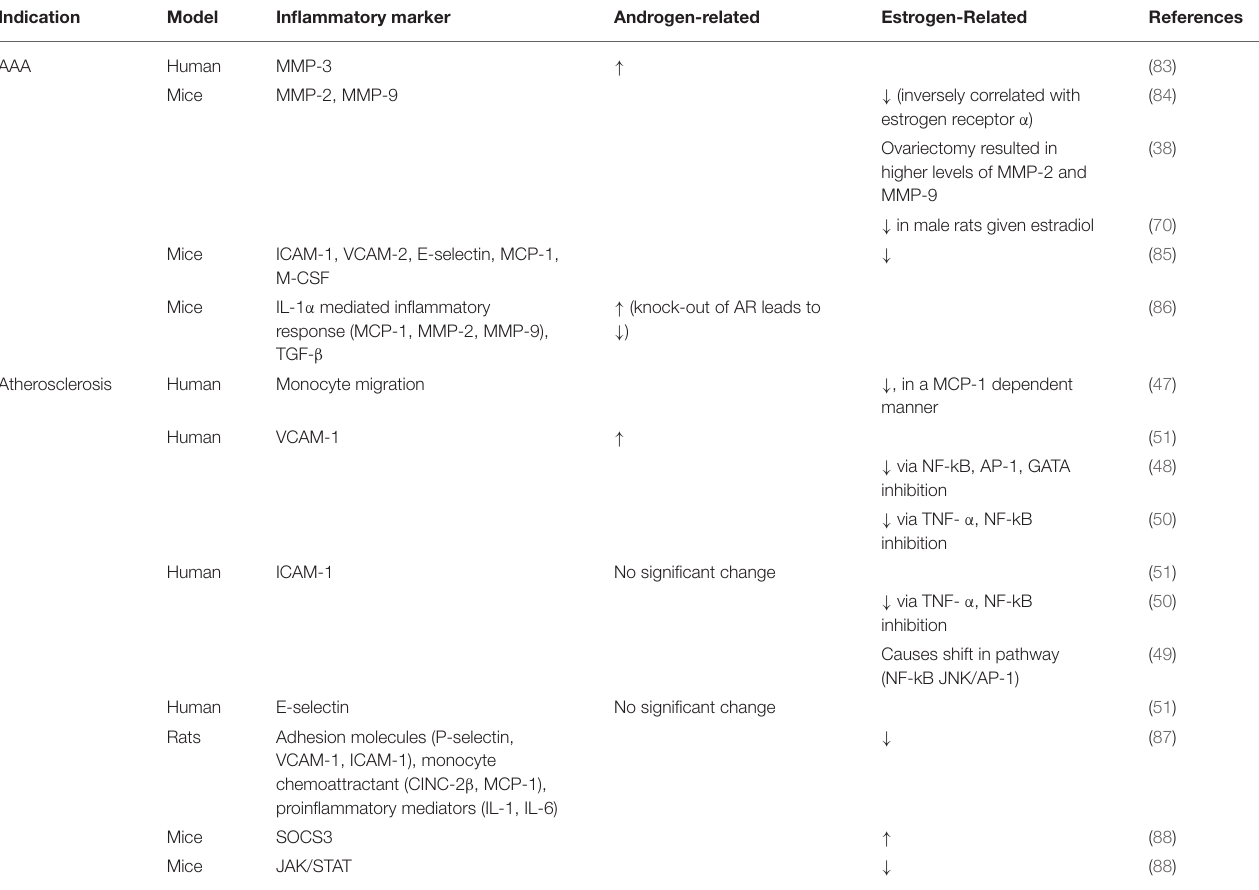
TABLE 2 | Differences in vascular inflammation due to sex hormones in clinical studies and animal models.